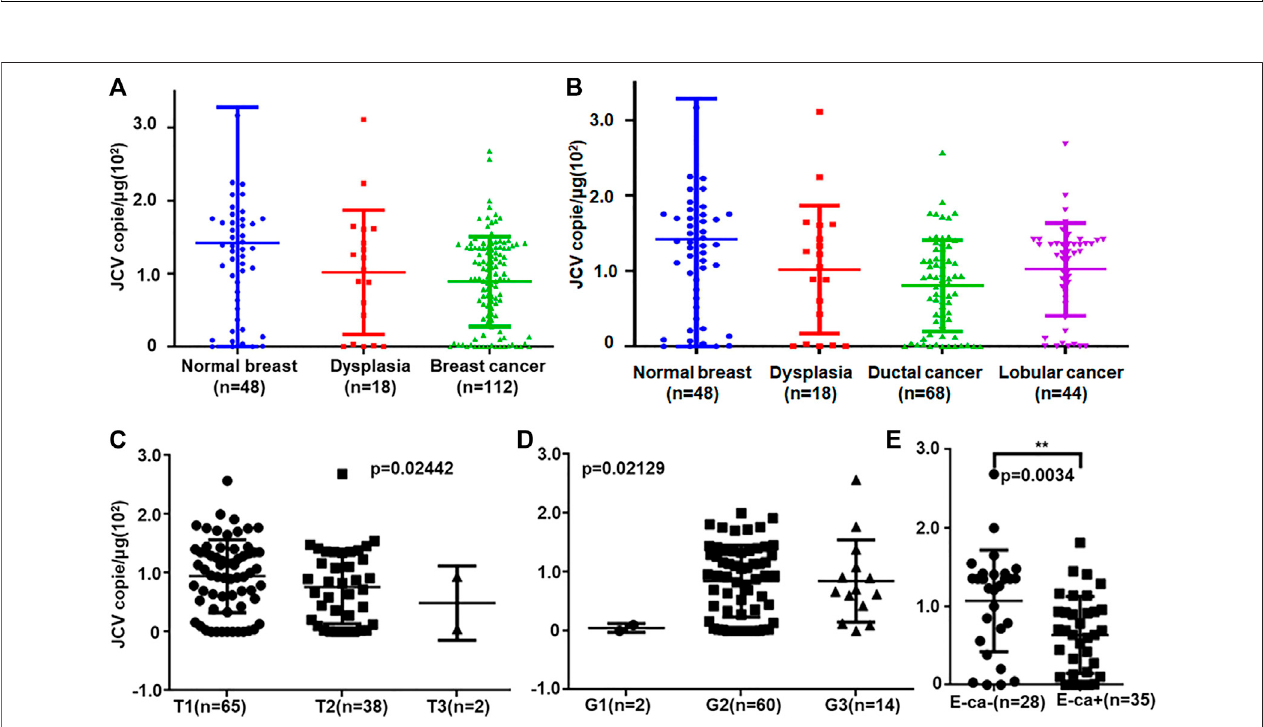
FIGURE 2 | JCV T antigen loads in breast cancers. T antigen copies were measured and calculated in normal, dysplasia, and cancer tissues byreal-time PCR (A) . The copies were analyzed between ductal and lobular cancers (B) . They were also compared with T staging (C) , G grading (D), and E-cadherin expression (E) . E-cad, E-cadherin